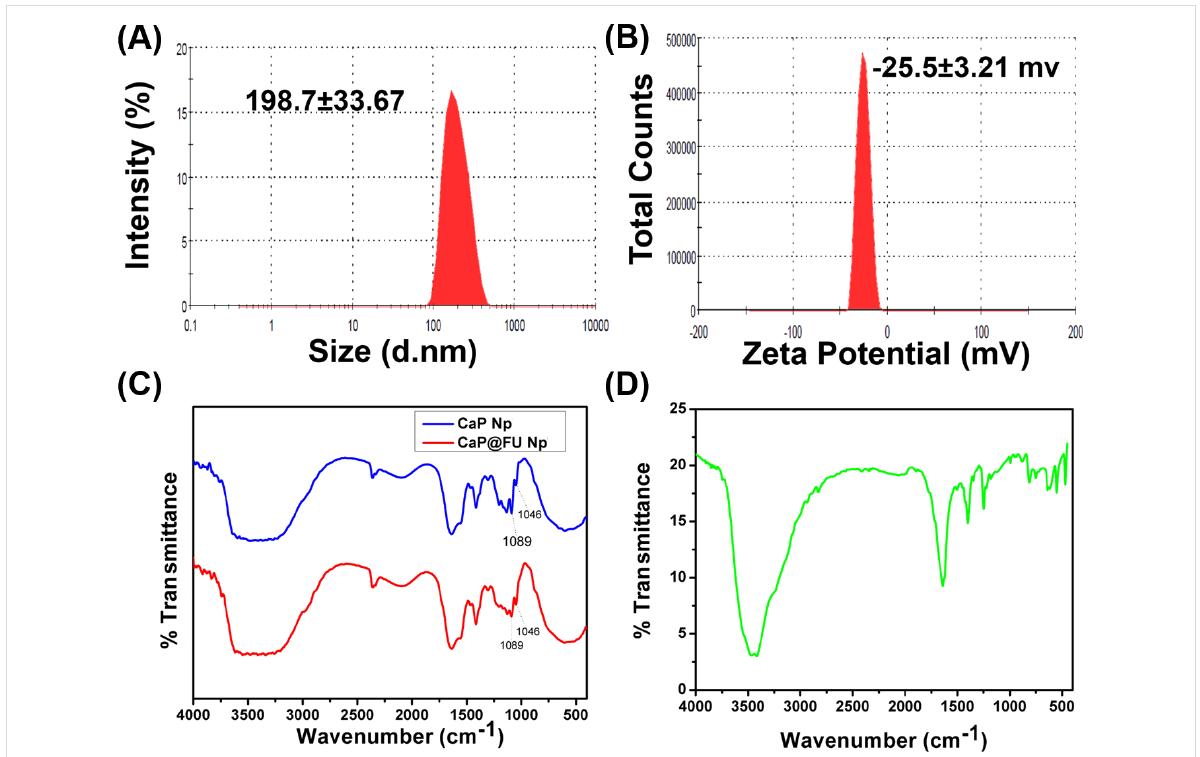
Figure 2: (A) The hydrodynamic diameter and (B) zeta potential of CaP@5-FU NPs in PBS buffer. (C) The FTIR spectra of CaP NPs (blue line) and CaP@5-FU NPs (red line) along with (D) 5-FU.